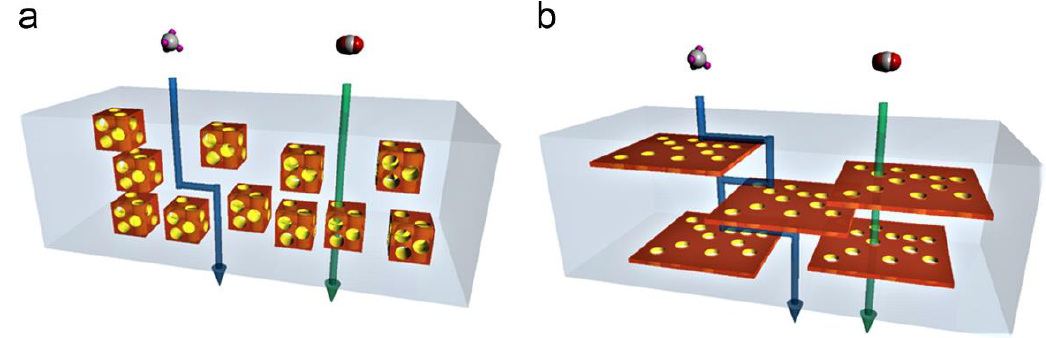
Figure 10. Schematic representation of the effect of isotropic particles ( a ) and nanoporous sheets ( b ) on the transport through mixed matrix membranes. Reprinted from [163], with copyright permission from © 2013 Elsevier.